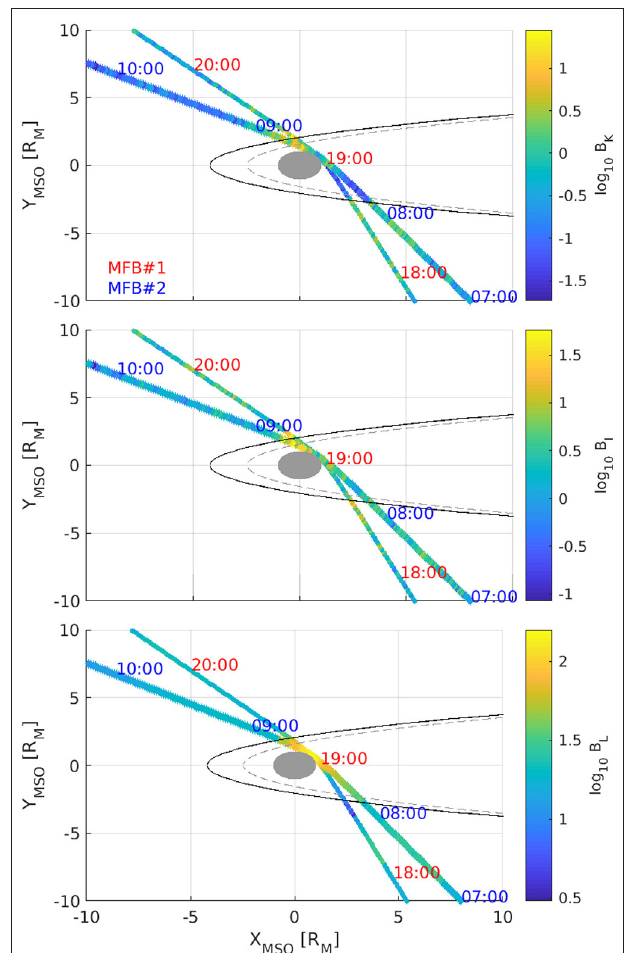
FIGURE 7 | The sub-ion/kinetic B K (top) , the MHD/inertial B I (middle) , and the large-scale B L (bottom) reconstructions for the magnetic field intensity (in logarithmic scale) along the trajectories of both Mercury flybys. The gray and the black lines correspond to the bow shock and magnetopause models [ 3, 24]. Time labels refer to the 2 days (i.e., January 14, 2008 and October 6, 2008) and are expressed in